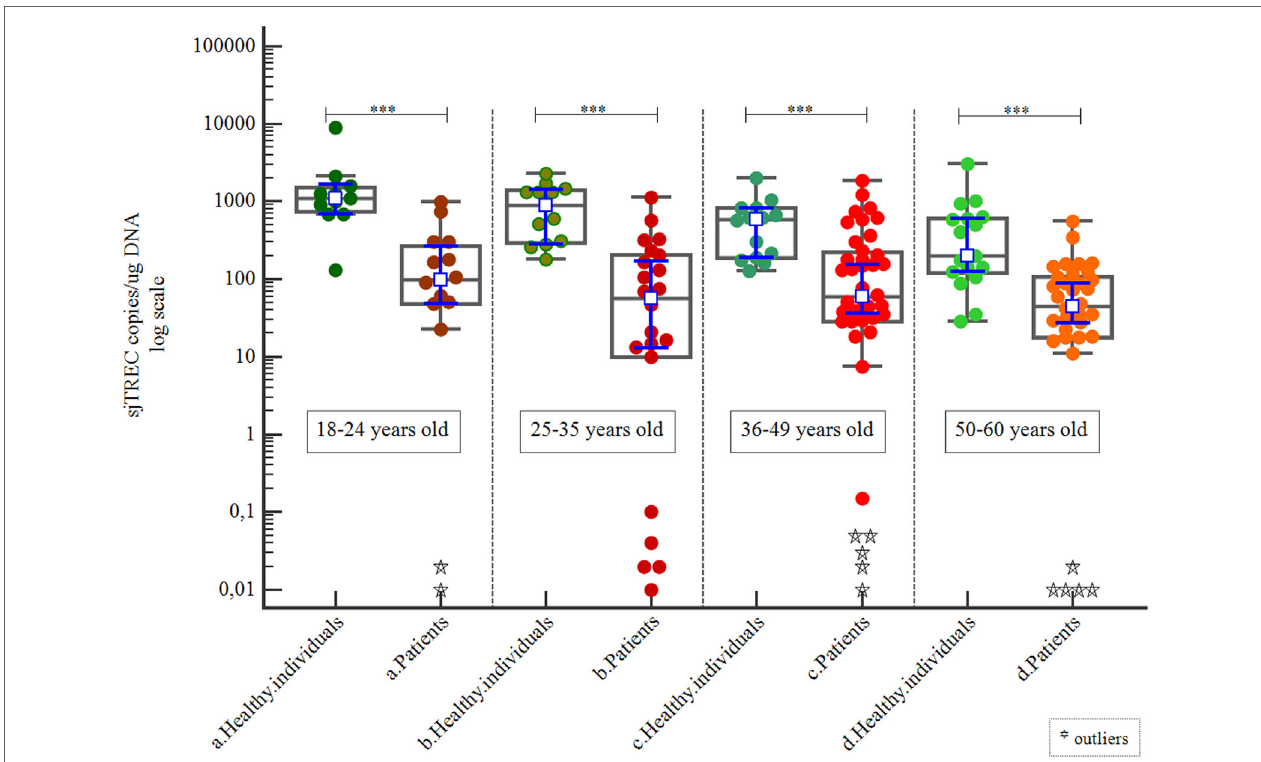
FigUre 3 | Correlation of signal joint TREC (sjTREC) count between healthy individuals and patients by age